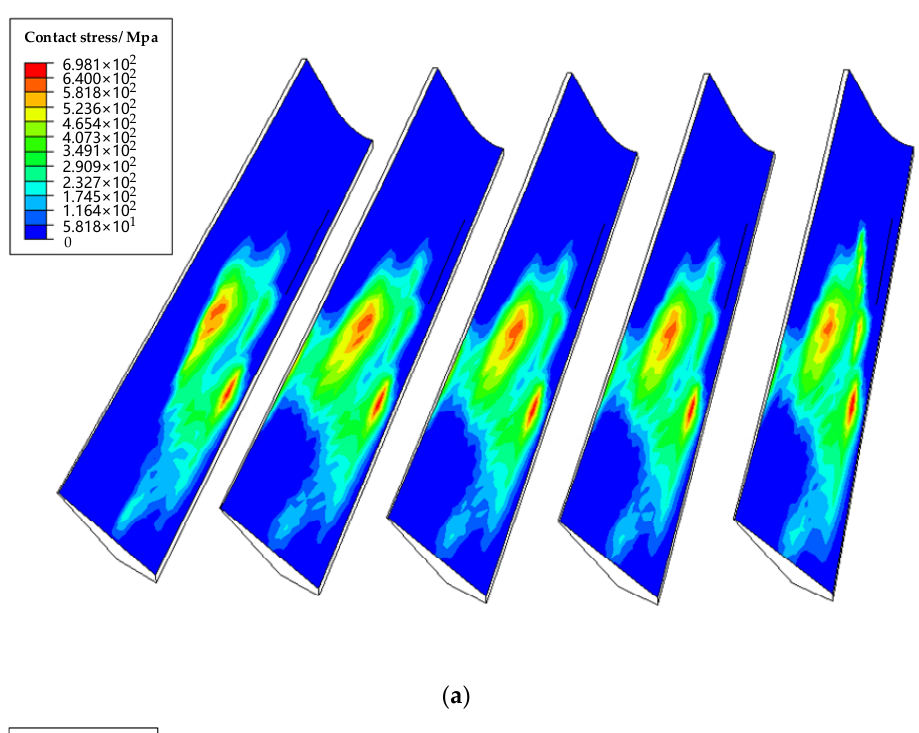
( b ) Figure 10. FEM: ( a ) Mesh generation, ( b ) the finite element model of real five-pairs-of-teeth face gear